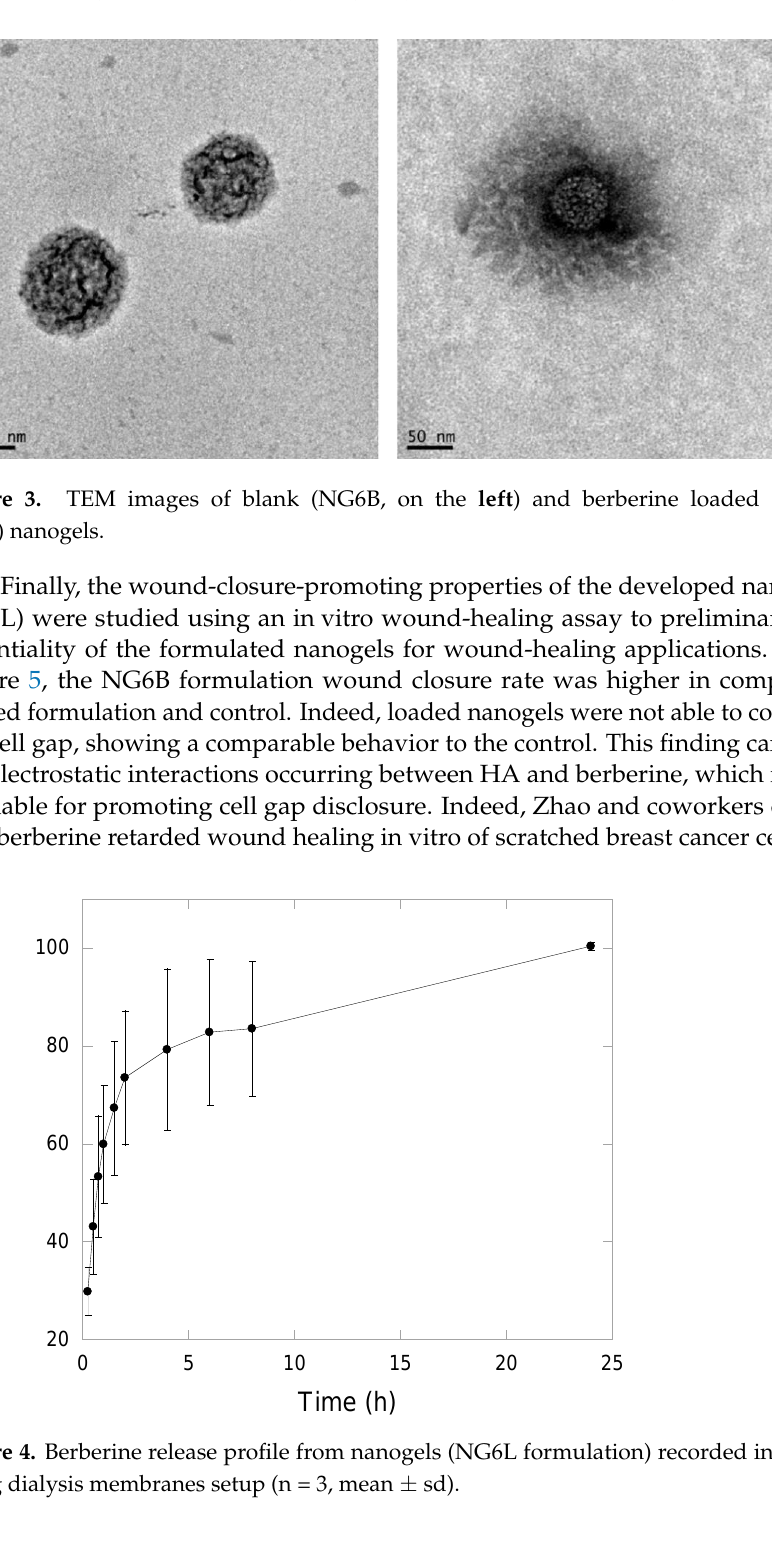
Figure 5. In vitro wound-healing assay photographs at 0, 18, 24, 28, 42, 48 and 52 h after incuba- tion with the samples (control row A, NG6B row B, NG6L row C) at 37 °C in 5% CO 2 and 95% rela- tive humidity, and percentages of cell gap as a function of time.